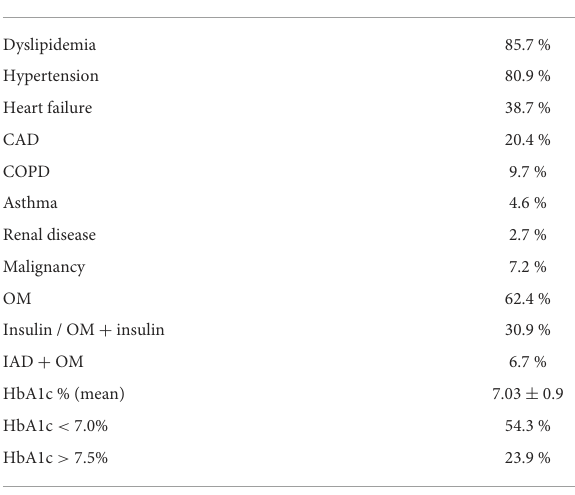
TABLE 1 Percentage of T2D individuals with accompanied diseases and T2D related features.